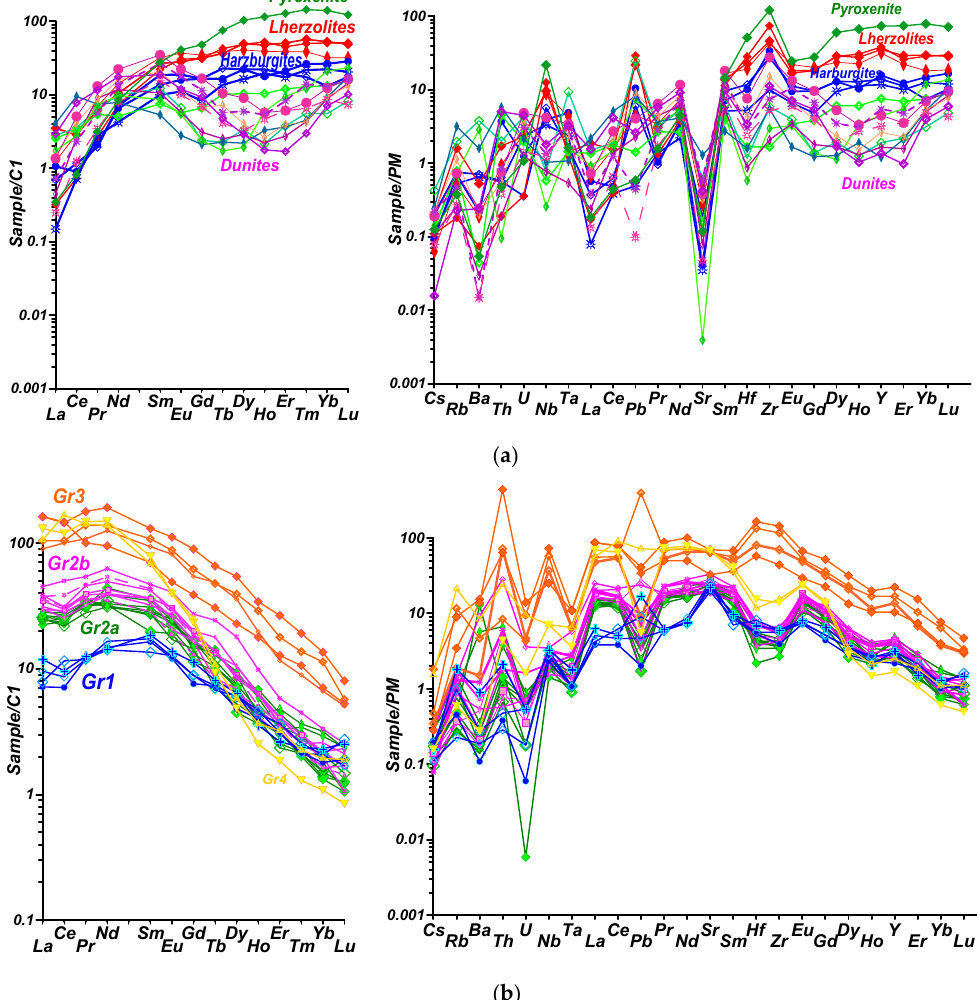
Figure 10. REE and spider-diagrams for ( a ) for Cr-bearing garnets, ( b ) Cr-diopsides from mantle xenoliths of Zapolyarnaya pipe. Normalization to chondrite C1 [17] and primitive mantle [32].